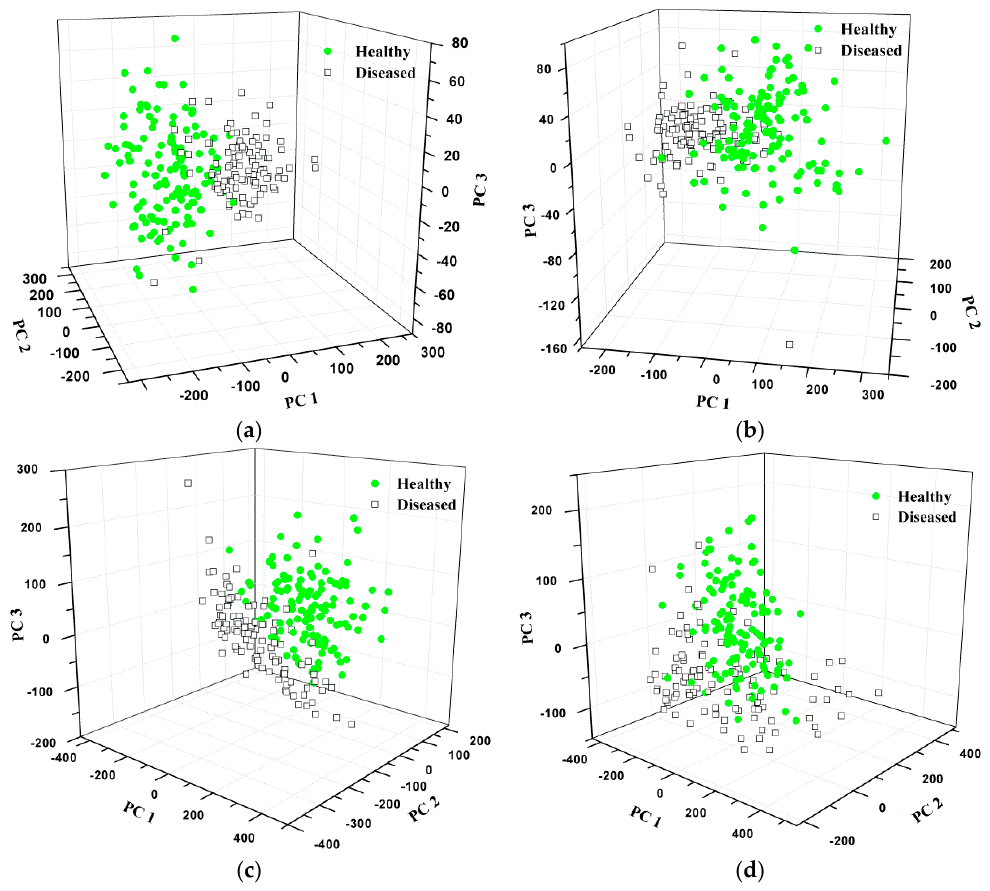
Figure 9. Samples distribution of PCA based on ( a ) gray images; ( b ) RGB images; ( c ) HSV images; and ( d ) HLS images.